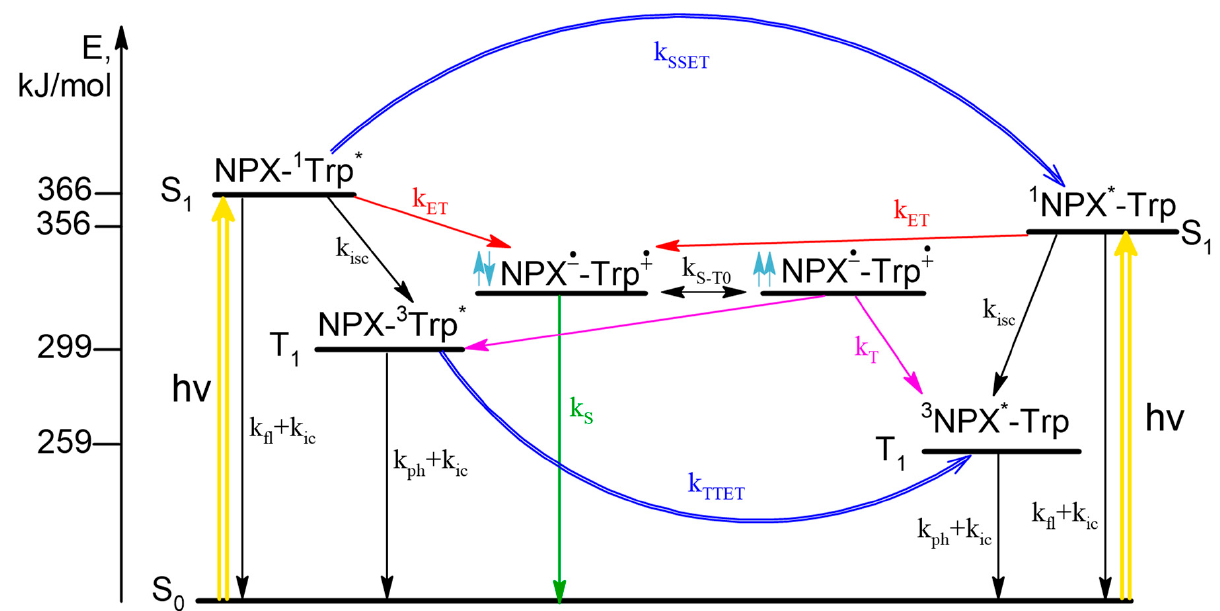
Figure 3. The corrected fluorescence emission spectra of KP-Trp dyad compared to the parent N- acetyl-tryptophan methyl ester in acetonitrile, λ exc = 280 nm. Such low fluorescence quantum yield was accounted for concurrent SSET and ET (Scheme 2).